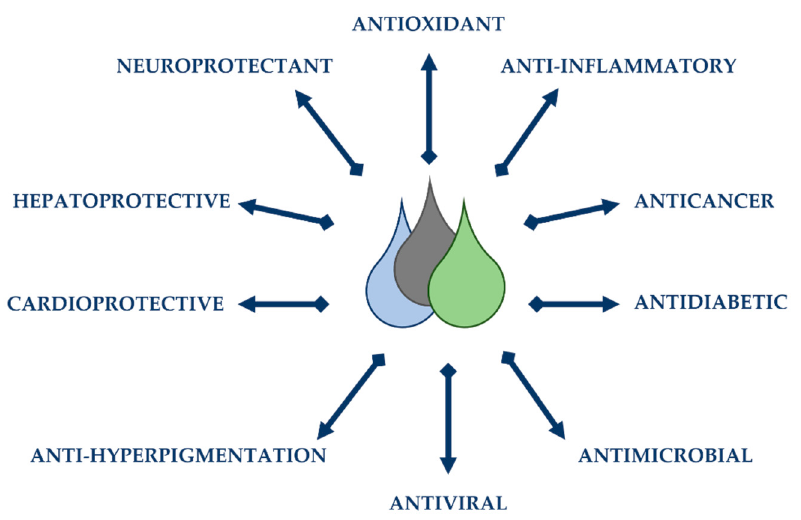
Figure 1. Biological activities of essential oils.